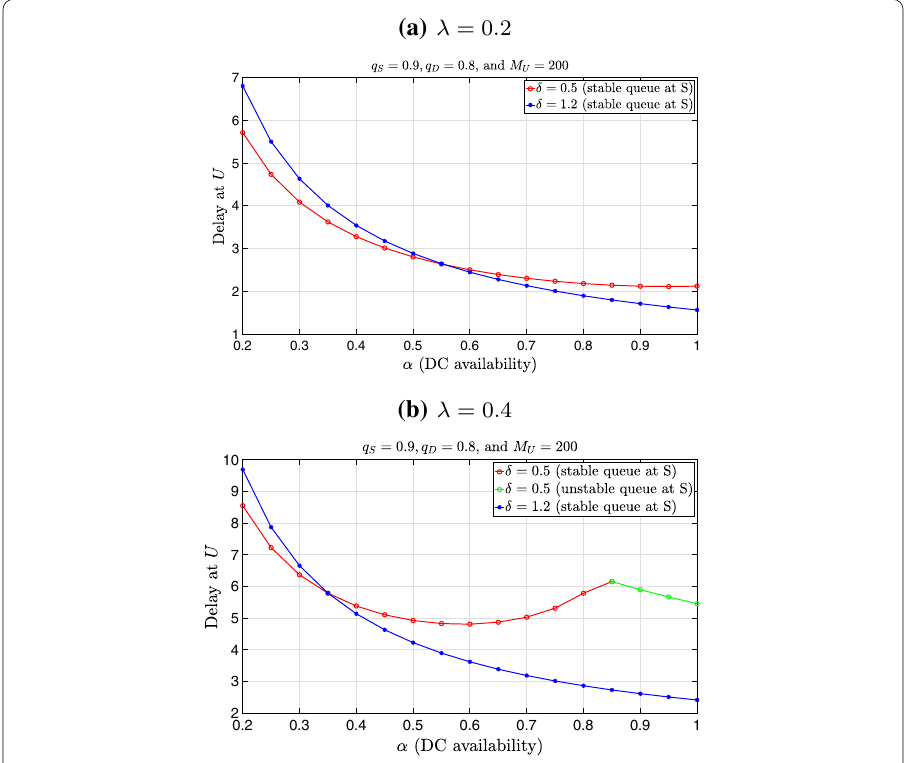
Fig. 11 The average delay at U vs. α for δ ∈ { 0.5,1.2